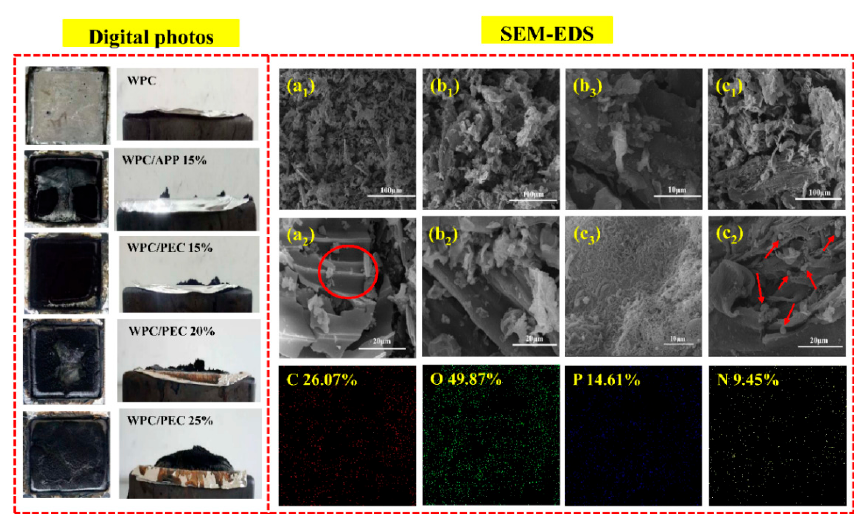
Figure 5. Digital photos of char residues from CCT, and their SEM images of WPC ( a 1 , a 2 ), WPC/APP 15% ( b 1 , b 2 , b 3 ), and WPC/PEC 15% ( c 1 ,c 2 ,c 3 ) and its EDX pattern of char residues.